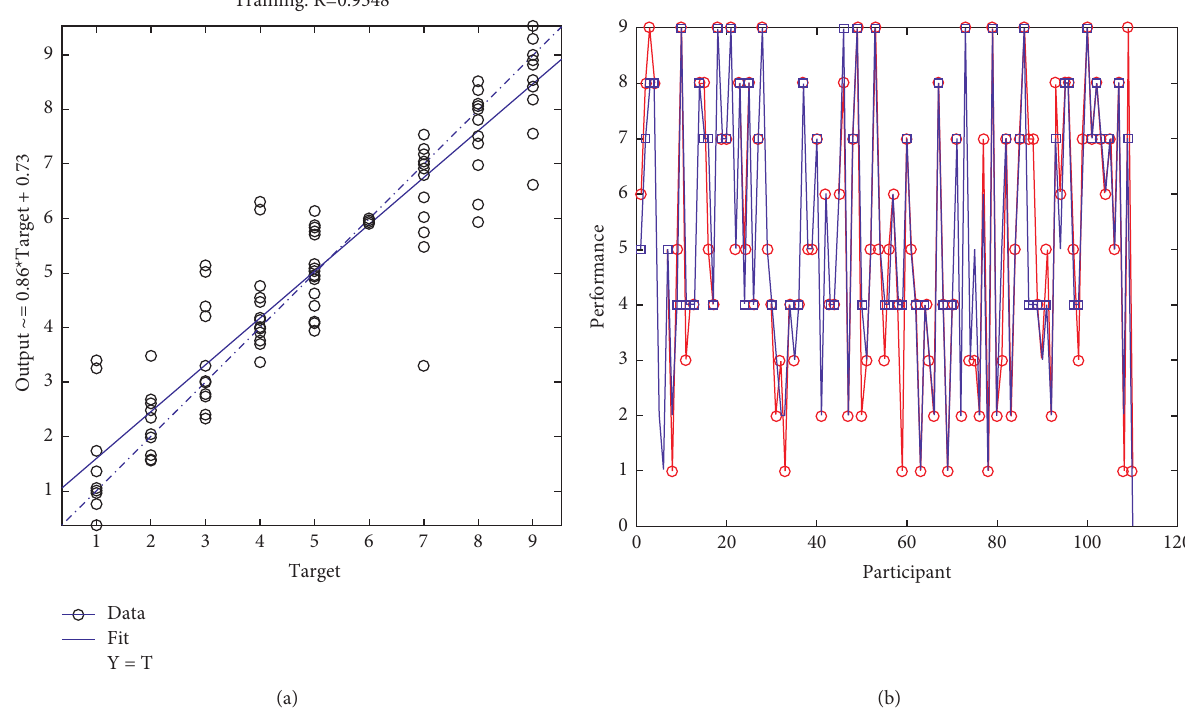
Figure 6: Results of the DINN method for performance prediction. (a) Scatter plot of the performance and (b) the observation plot of the performance of management control